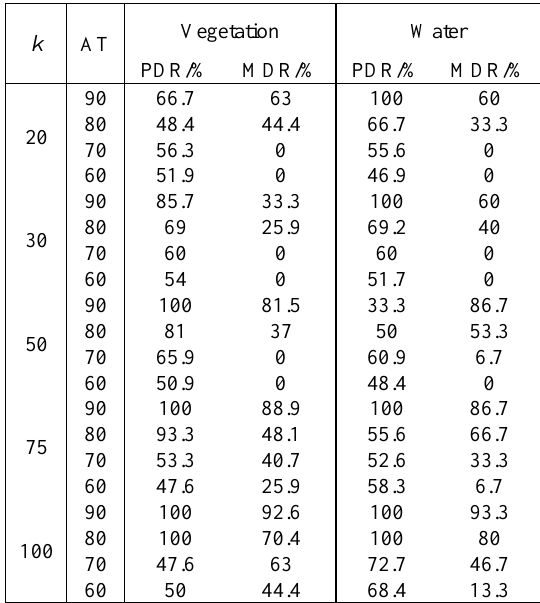
When calculating the local reachable density, the value of k will affect the calculation result of the abnormality index. Tables 1 shows the sample abnormality inspection accuracy when the abnormality threshold is set to 60% or more under different k values. Among them, the abnormality threshold (AT) represents the FSOI values, the positive detection rate (PDR) represents the Fig 3. The interface of abnormal crowdsourced data detection total number of correct detections divided by the total number of prototype system abnormalities detected, and the missed detection rate (MDR) represents the total number of true abnormalities minus the total number of correct detections and then divided by the total